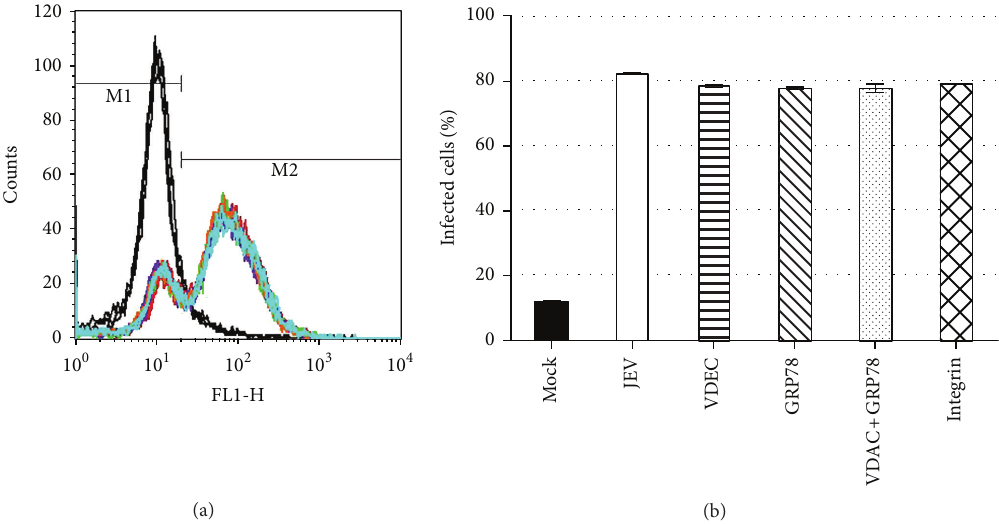
Figure 2: Antibody inhibition analysis of JEV entry to insect cells. C6/36 cells were pretreated with antibodies against GRP78, VDAC, VDAC, and GRP78 and integrin 𝛼 V/ 𝛽 5 or no antibody before infection with JEV at MOI of 10. After 8 hours the percent infection was determined by flow cytometry. Representative raw data profiles (a) and tabular analysis (b) from three independent experiments in duplicate are